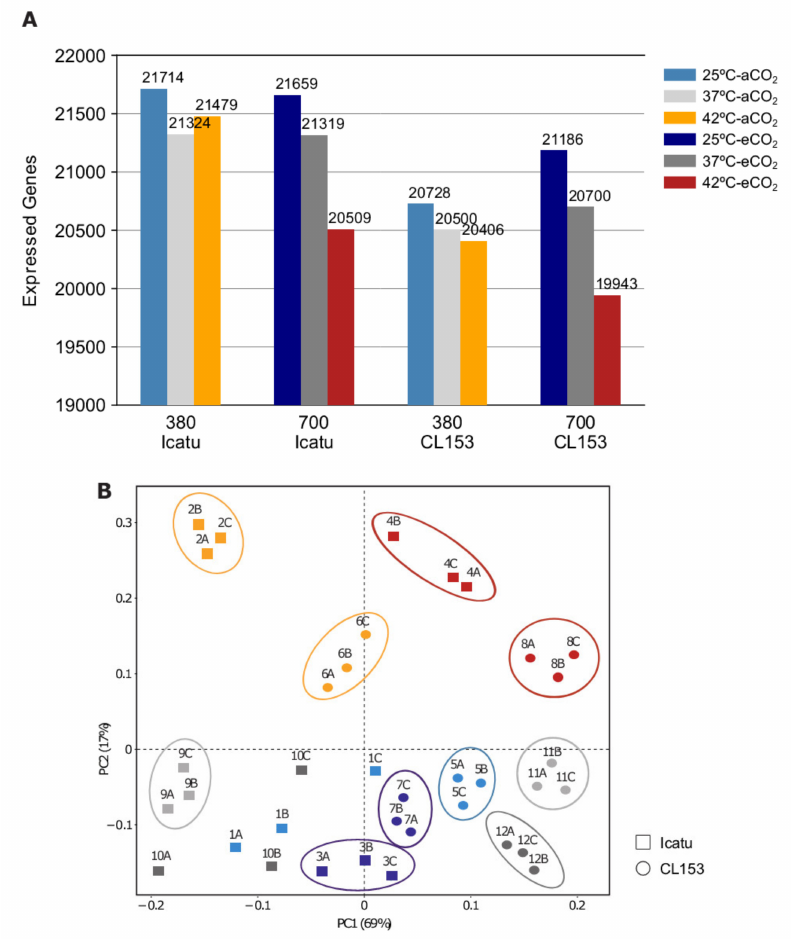
Figure 1. Differences in the patterns of gene expression. ( A ) Number of expressed genes in plants of C. arabica cv. Icatu and C. canephora cv. Conilon Clone 153 (CL153), grown either in ambient CO 2 (aCO 2 , 380 µ L L − 1 ) or elevated CO 2 (eCO 2 , 700 µ L L − 1 ) air at control temperature conditions (25/20 ◦ C, day/night; 25 ◦ C), a moderate supra-optimal temperature (37/28 ◦ C; 37 ◦ C), and an extreme supra-optimal temperature (42/30 ◦ C; 42 ◦ C). ( B ) Principal coordinate analysis (PCoA) of rlog transformed gene expression data generated by RNA-sequencing. Each treatment contains three biological replicates and is indicated by the colors depicted in A. The percentage of variance is indicated in each axis. Square symbols indicate Icatu, while circles indicate CL153. Detailed information is additionally given in Table